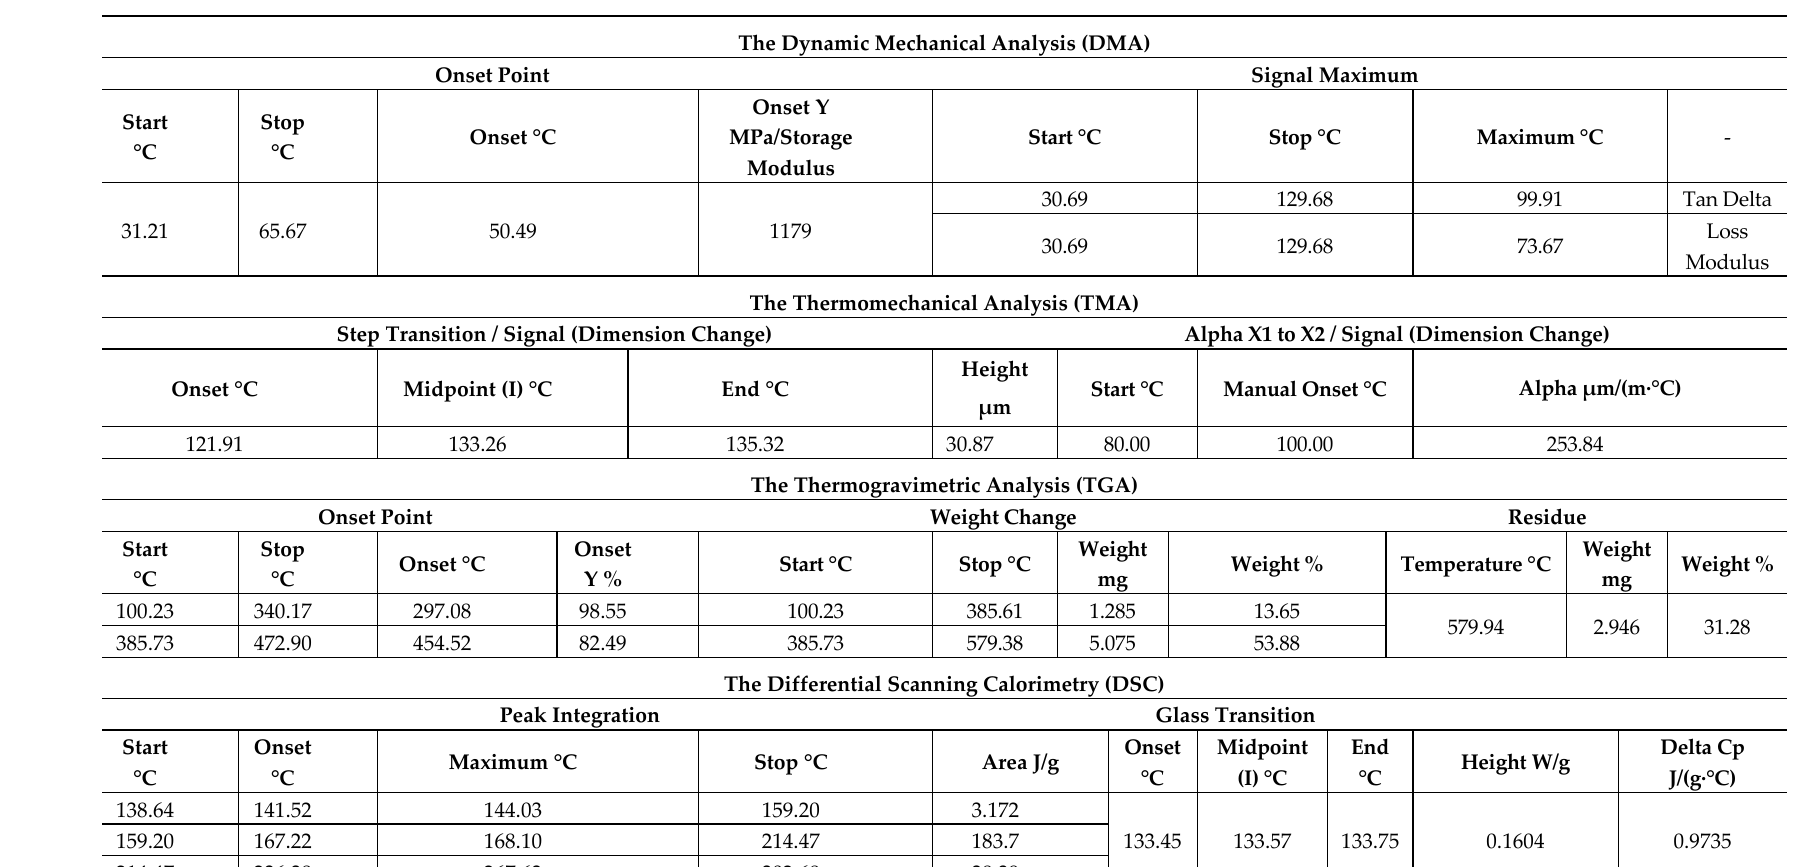
Table 1. A comprehensive process analysis on the thermal procedure with numerical results.